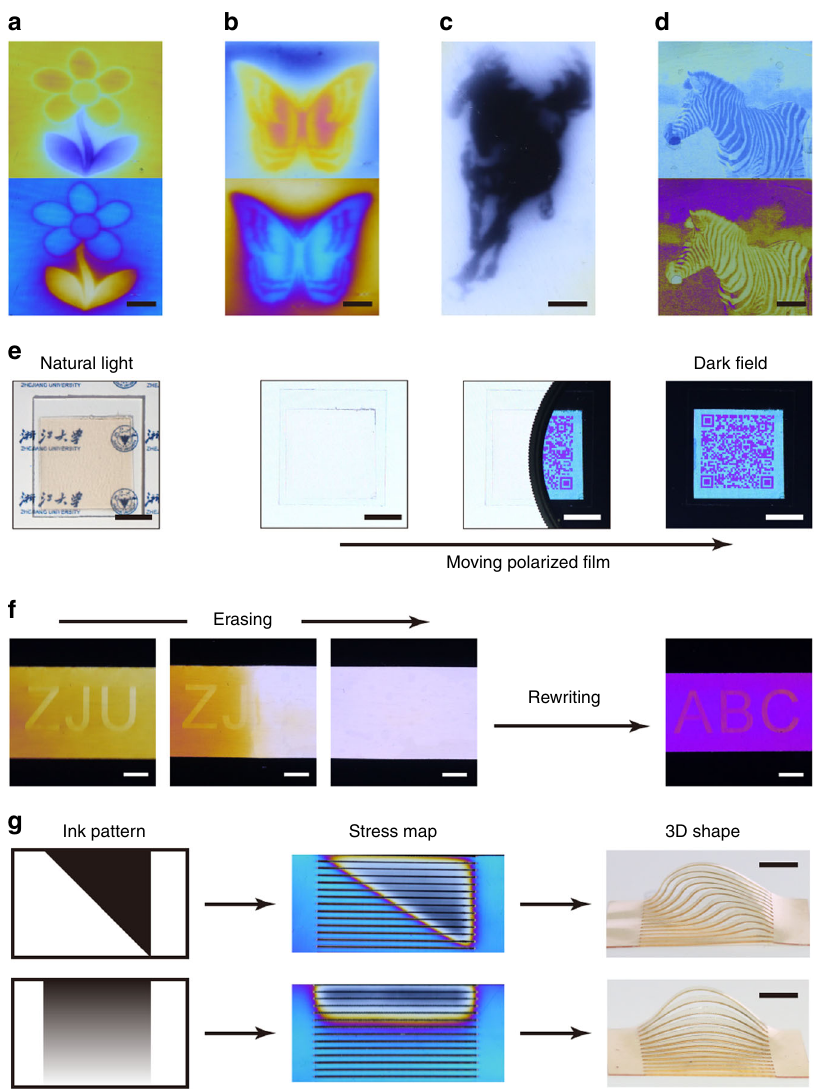
Fig. 4 Stress-induced mechanically colored images. a , b Flower and butter fl y painting in bright (upper) and dark fi eld (lower). c Horse painting in Chinese traditional style. d Images of zebra created via laser direct writing in bright (upper) and dark fi eld (lower). e Invisible quick response code. f Erasing and rewriting letters. g Controlled formation of three-dimensional shapes via heating-induced release (60 °C) of digital stress patterns in two-dimensional free- standing fi lms (black lines in the stress maps represent laser-cut through patterns). All the scale bars are